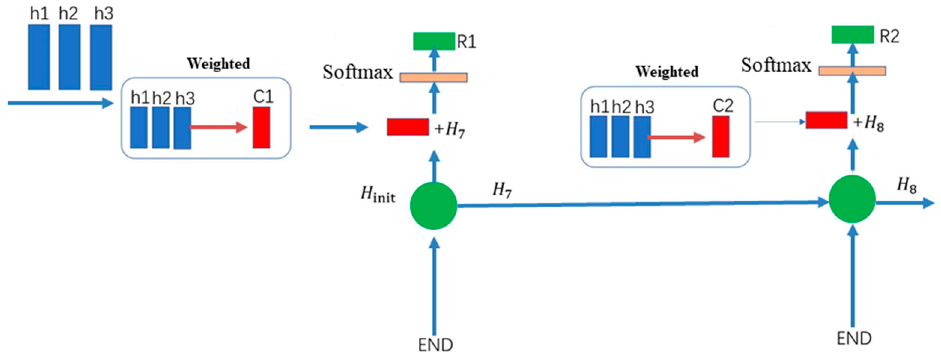
Figure 7. Attention